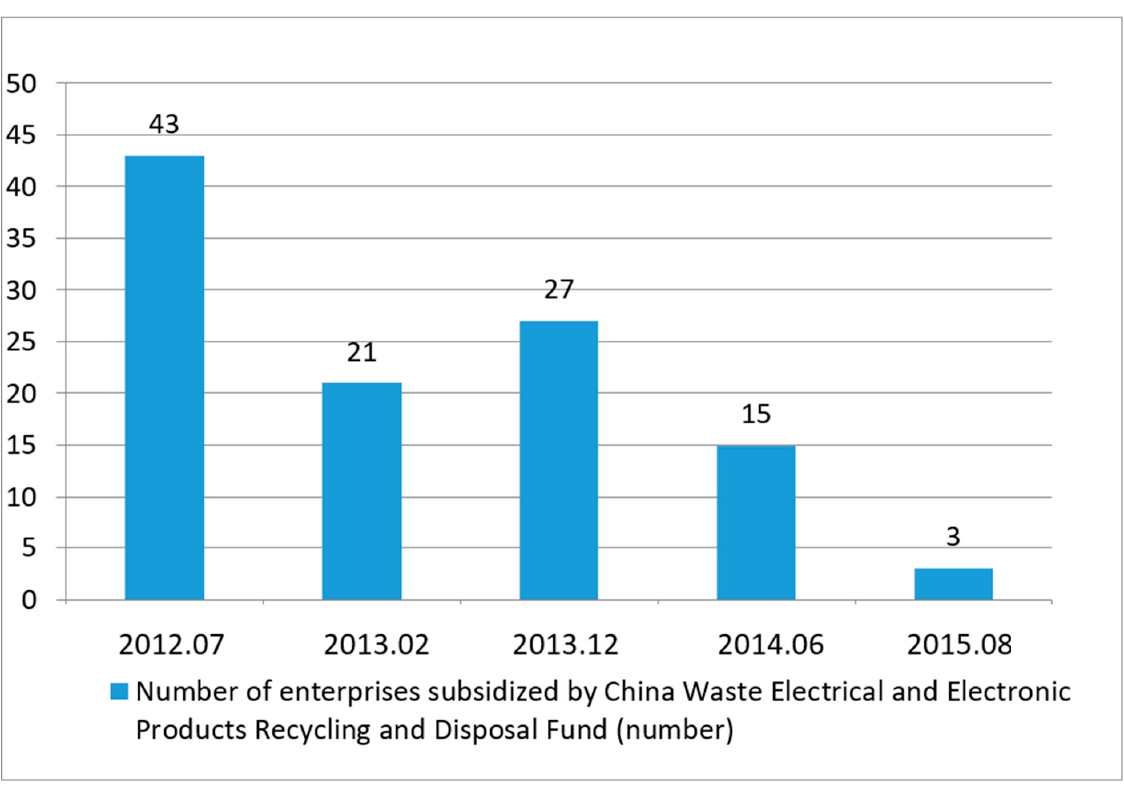
Figure 8. Number of enterprises subsidized by the recycling fund for WEEEs in China from 2012 to present.